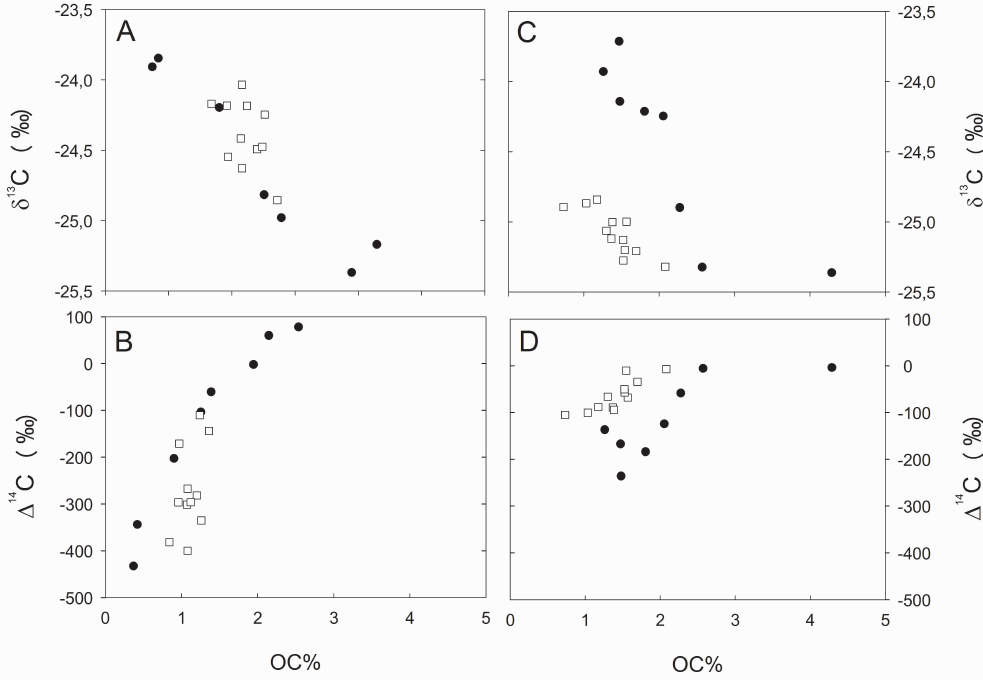
Fig. 5. 1 14 C, δ 13 C, and OC % in C51 ( A and B ) and C24 ( C and D ). Black dots represent soil samples and white squares sediment samples.